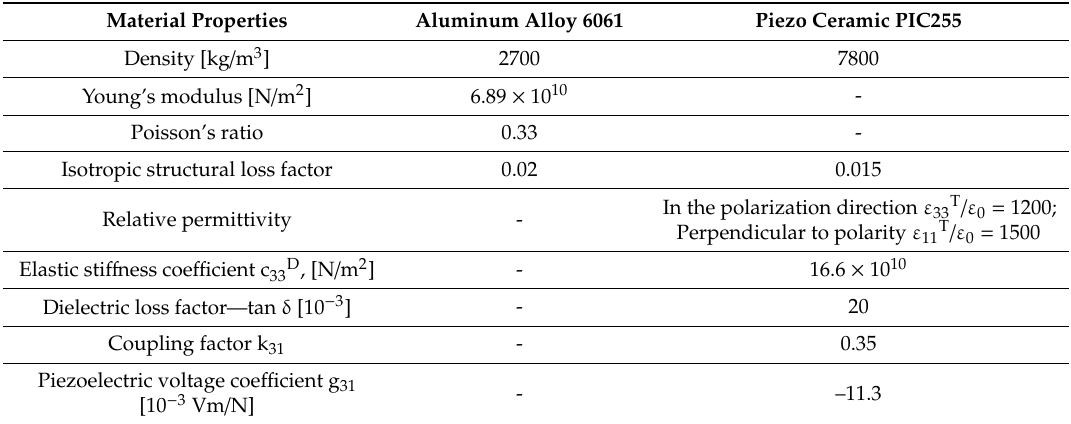
Table 1. Material properties.